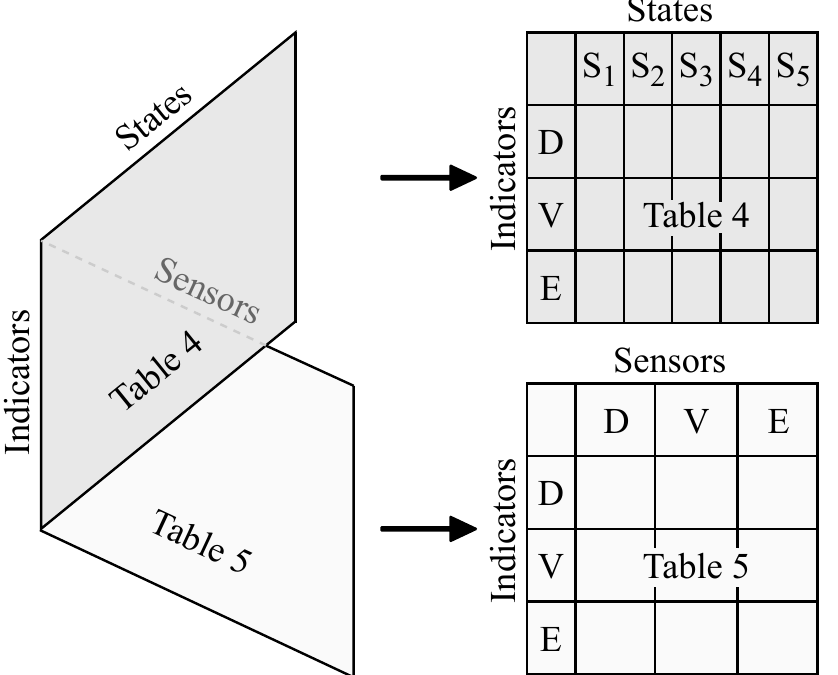
Figure 3. The figure shows simplified representations of key Table 4 (states vs. indicators) and Table 5 (sensors vs. indicators). It also suggests that these tables can naturally be interpreted as being two views of an underlying 3D array. S i , D, V, and E stand for “State i”, “Driver”, “Vehicle”, and “Environment”,